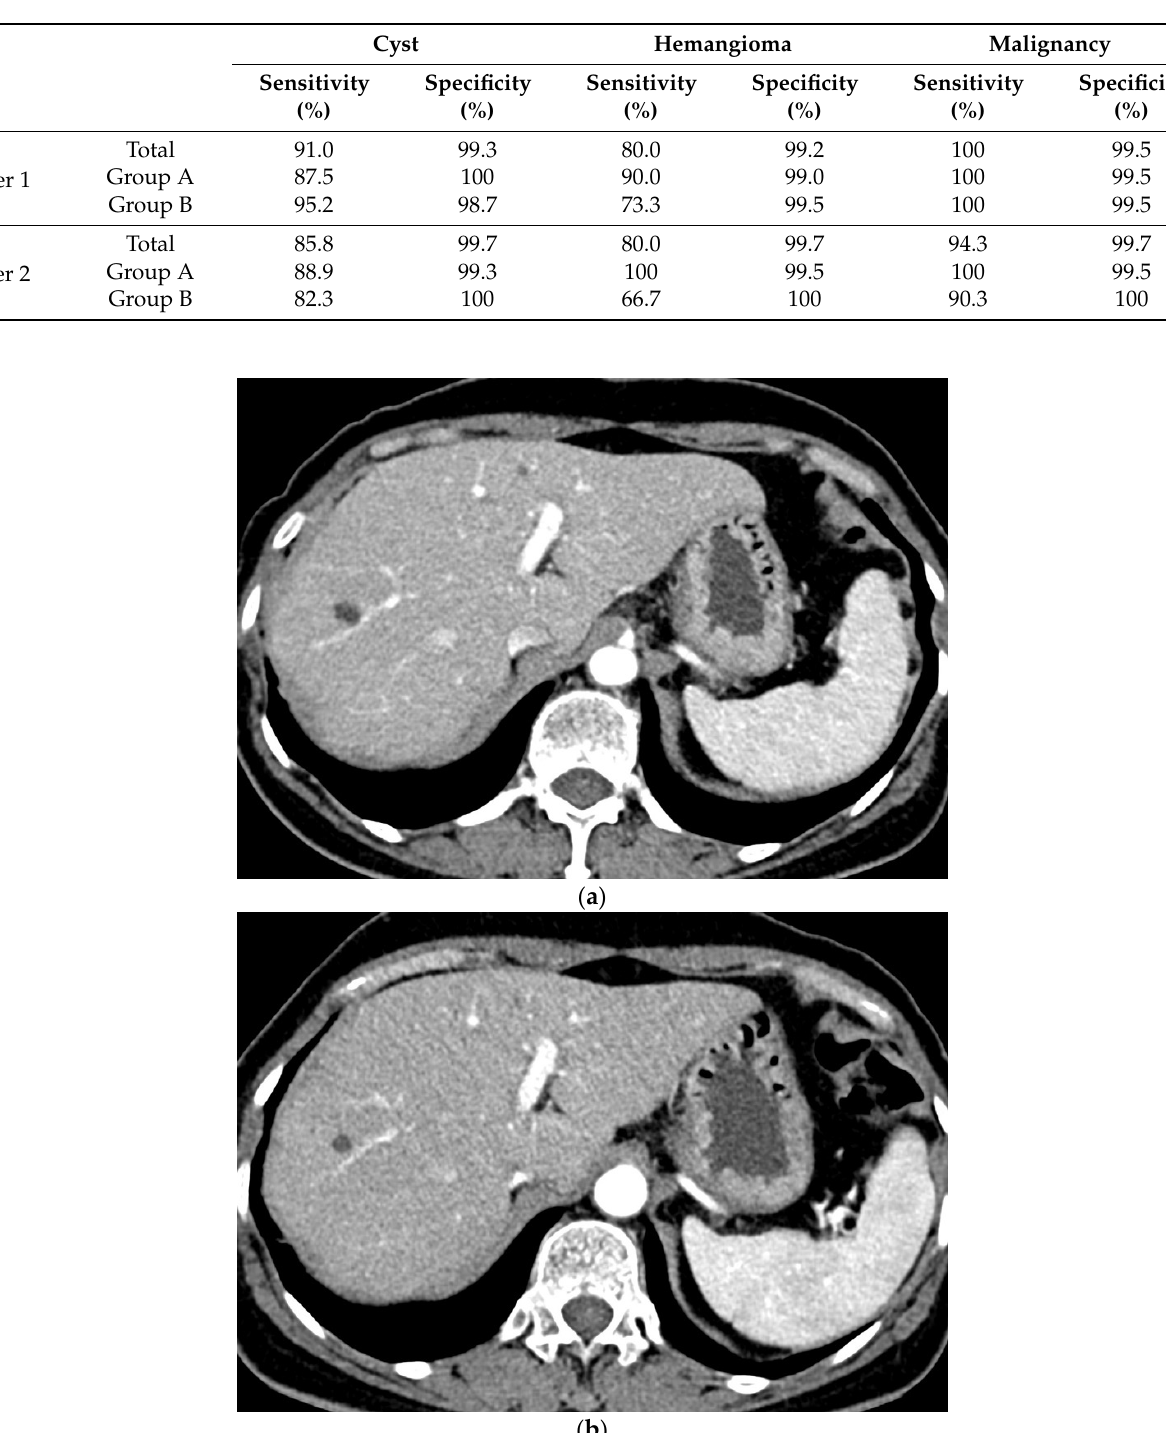
Table 6. Diagnostic performance in all the patients and in the two groups.